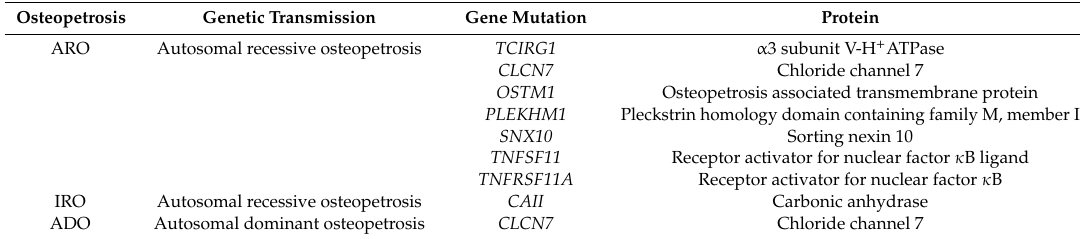
Table 1. List of genes mutated in osteopetrotic